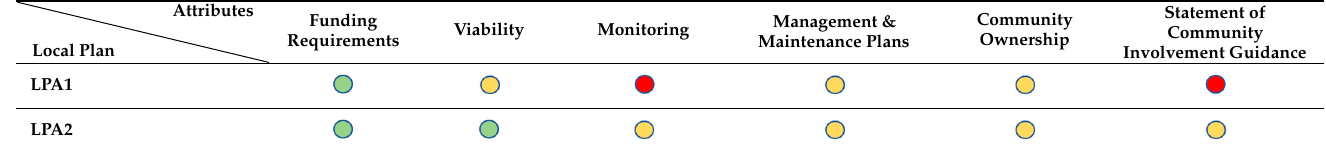
Table 3. Local plans and health requirements for developers. Table 4. Local plan and implementation of health requirements.